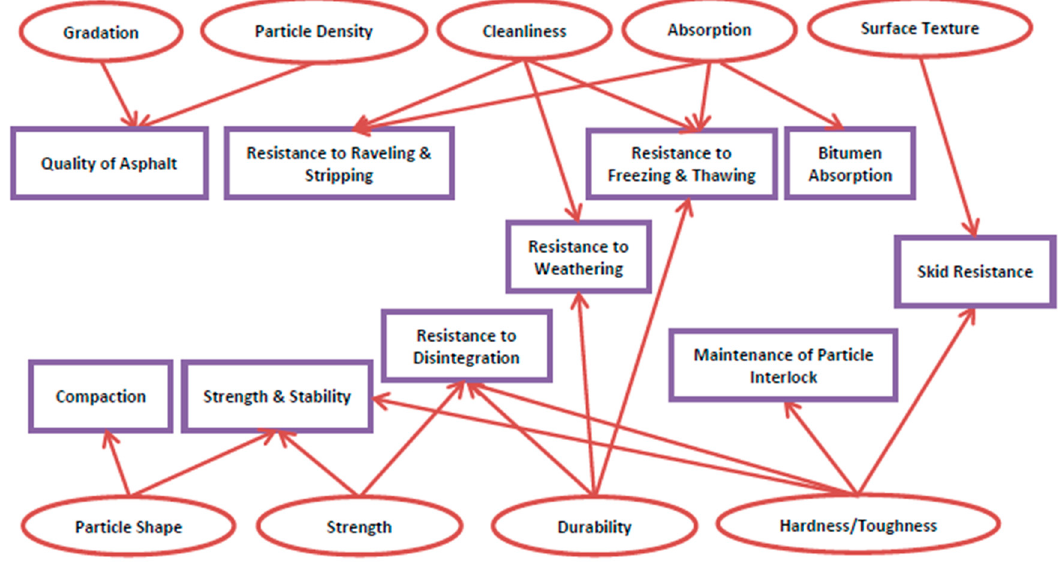
Figure 1. A Summary of the Effects of Aggregate Properties on the Asphalt Performance.